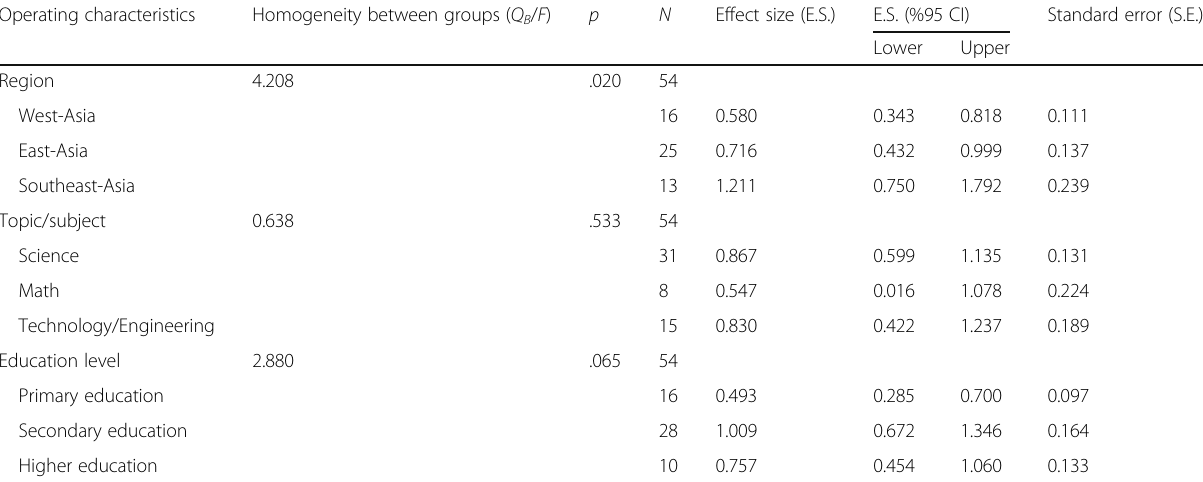
Table 1 Statistical analysis of the study characteristics Operating